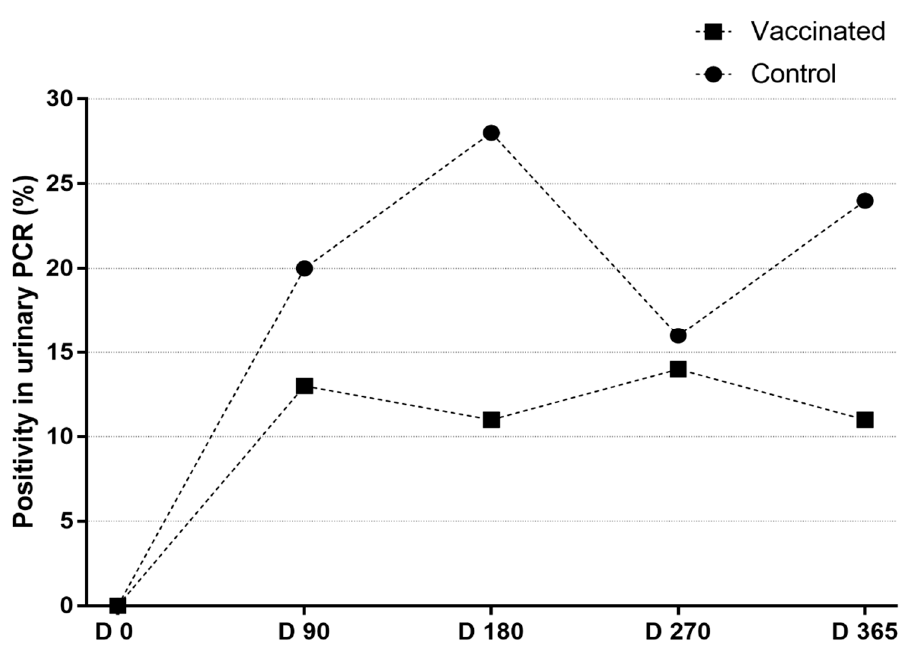
Figure 3. Temporal description of PCR results on vaccinated and unvaccinated groups of dogs.